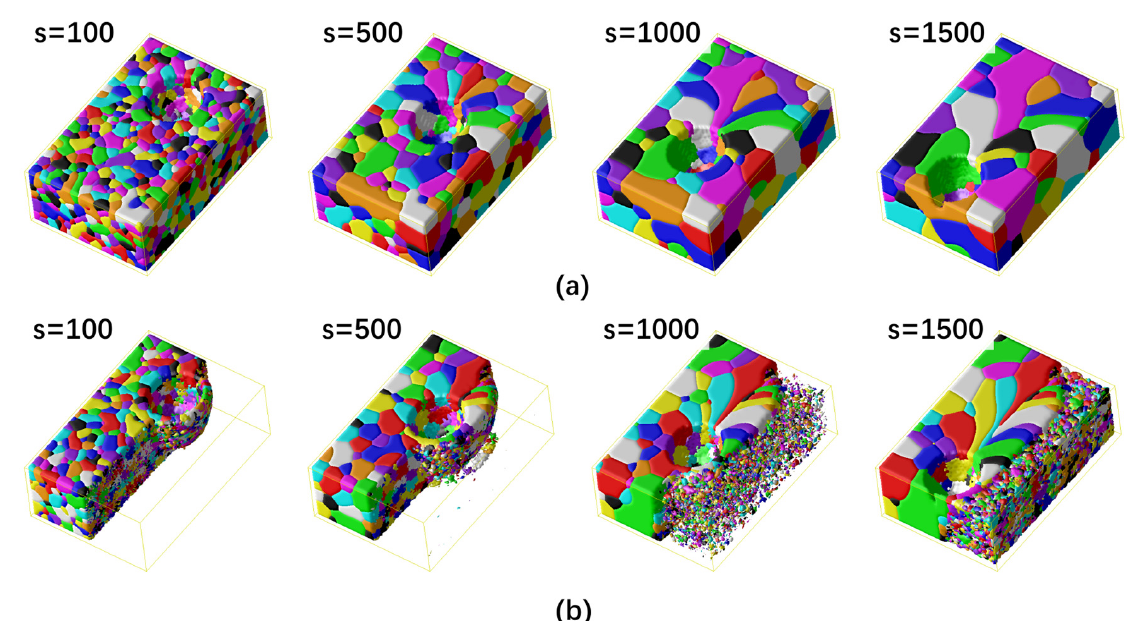
Figure 7. Temporal evolution of the grain structures during the welding of ( a ) two Fe–6.5 wt.% Si alloys and ( b ) Fe–6.5 wt.% Si alloy and low-carbon steel after different simulation steps. The different colors in the simulated grain structure represent the different orientations of the grains.